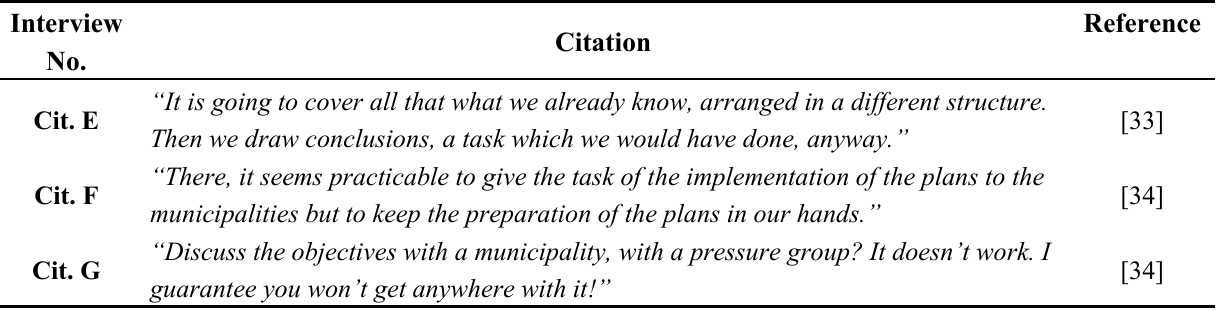
Table 3 . Citations revealing a pro-forma implementation strategy.